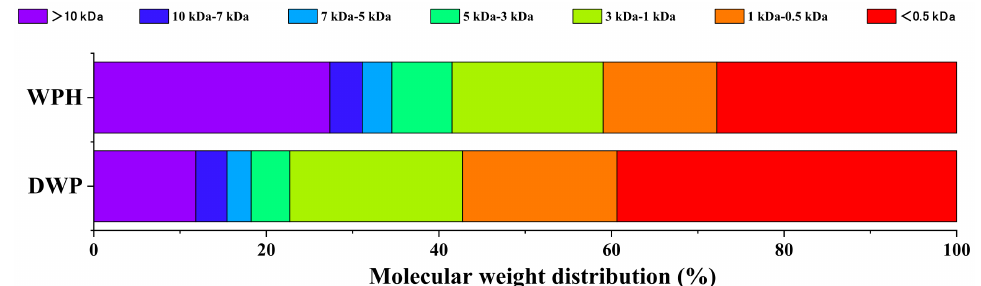
Figure 3. The molecular weight distribution of whey protein hydrolysate (WPH) and its digestive products (DWP).